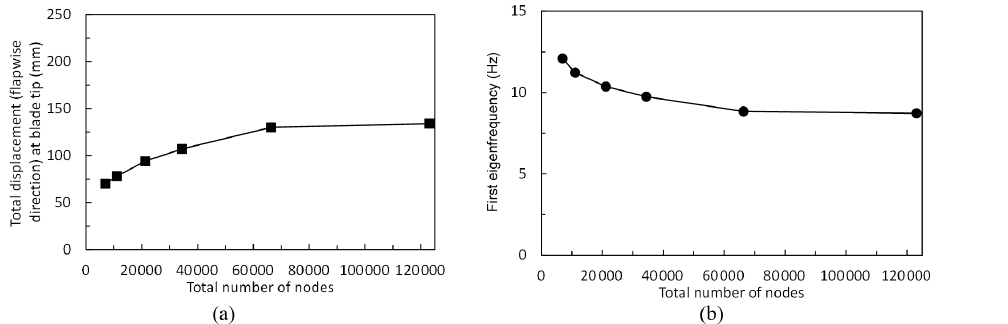
Figure 12. Mesh convergence study using (a) total number of nodes vs. total displacement (flapwise direction) at blade tip under flapwise loading and (b) total number of nodes vs. first